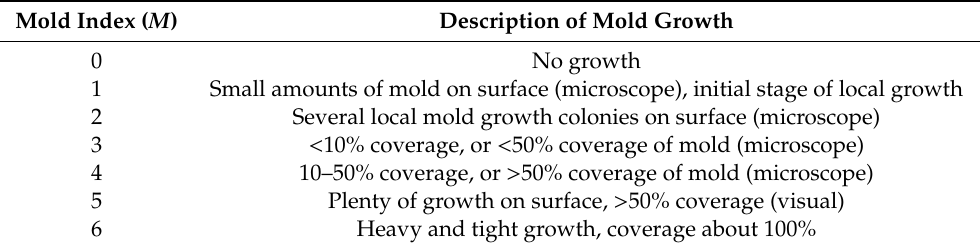
Table 4. Description of mold indexes